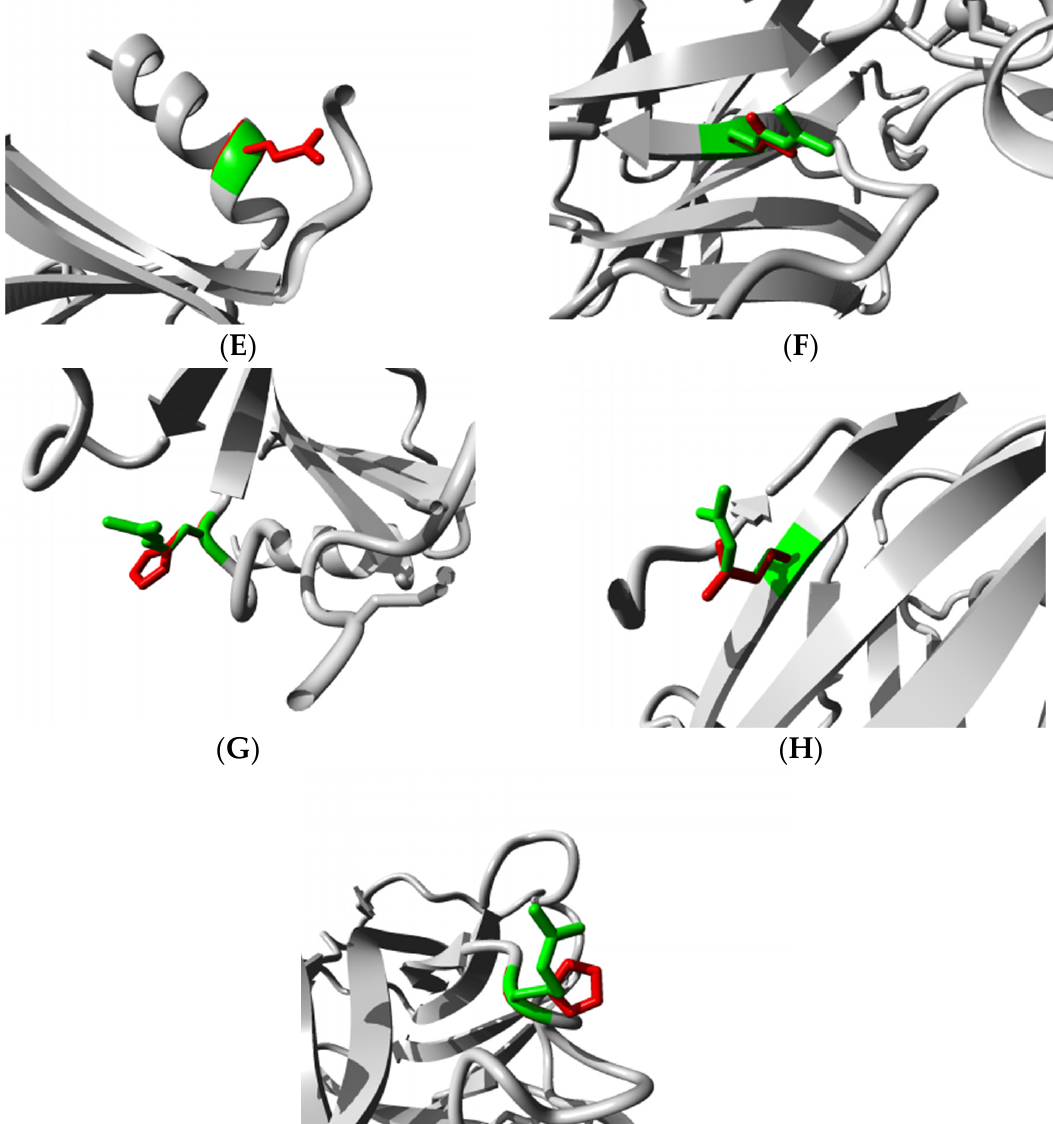
Figure 5. ( A – F ) The nine nsSNPs projected as harmful through all in silico tools. Image of the modified structure of TP63 protein was accomplished using Project HOPE. The native residue is indicated in green, and the altered residue for each SNP is depicted in red. Here, the side chain of the residue is displayed in color, and the whole protein is pictured in grey color. Notably, ( A ) C347F and ( E ) G349E show that modified residue which is in red is much bigger than native residue presented in green. In Figure 5B,C,E–I, the mutated residues are smaller than wild-type residue. In the case of ( B ) D351G, mutated G is not shown because of no side chain, and only wild-type residue is displayed in green. All of these structural changes retain detrimental impacts on the shape, conformation, and function of TP63. Note: ( A ) C347F, ( B ) D351G, ( C ) R343Q, ( D ) D355N, ( E ) G349E, ( F ) R266Q, ( G ) R319H, ( H ) R337Q, and ( I ) R318H. Figure panels ( A – F ) were downloaded from HOPE [42].